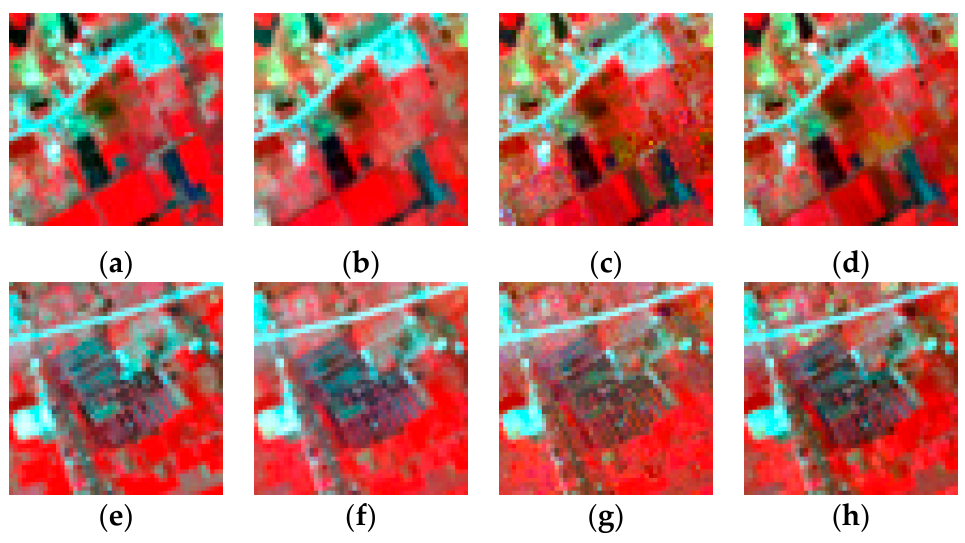
Figure 10. Zoomed-in images of the upper-right box ( top row ) and lower-left box ( bottom row ) marked